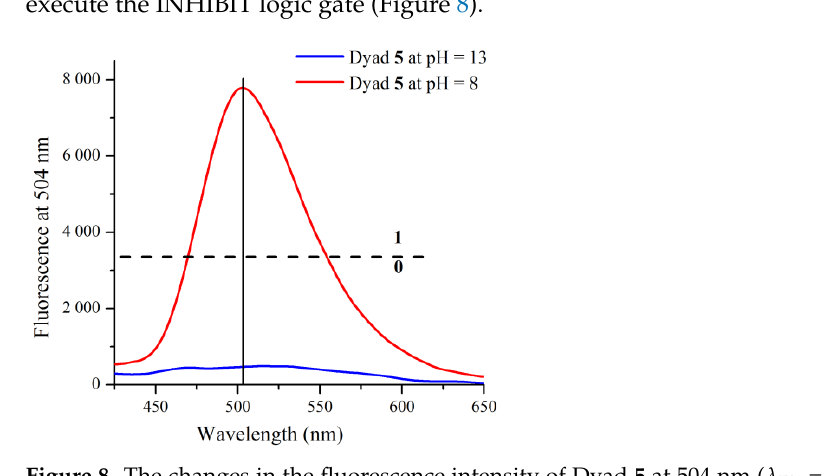
Figure 8. The changes in the fluorescence intensity of Dyad 5 at 504 nm ( λ EX = 400 nm) with two chemical inputs (Output 3, Table 2).